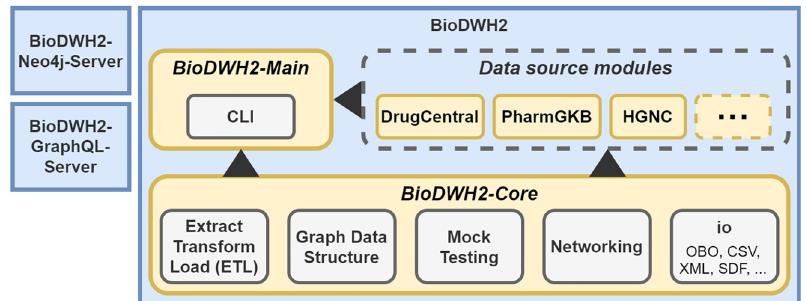
Figure 1: Architecture of Bio-